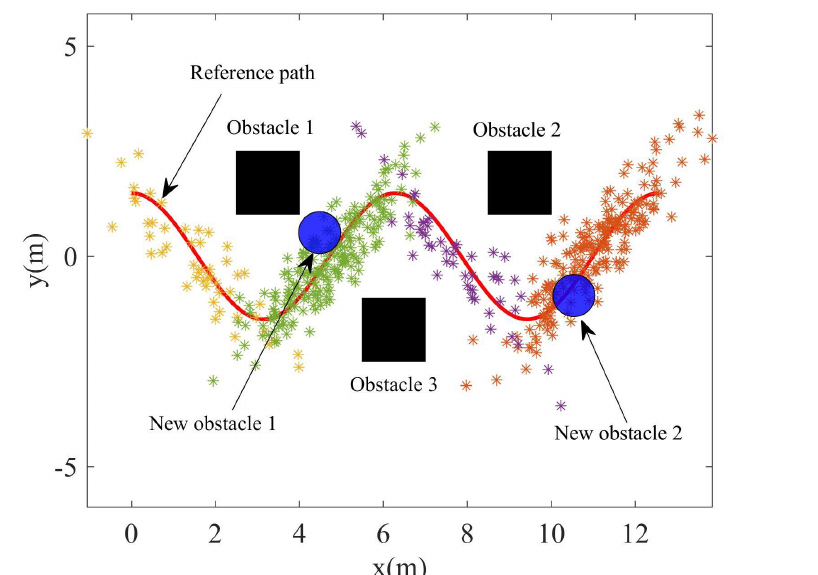
Figure 6. The recurrent scene with two new obstacle.